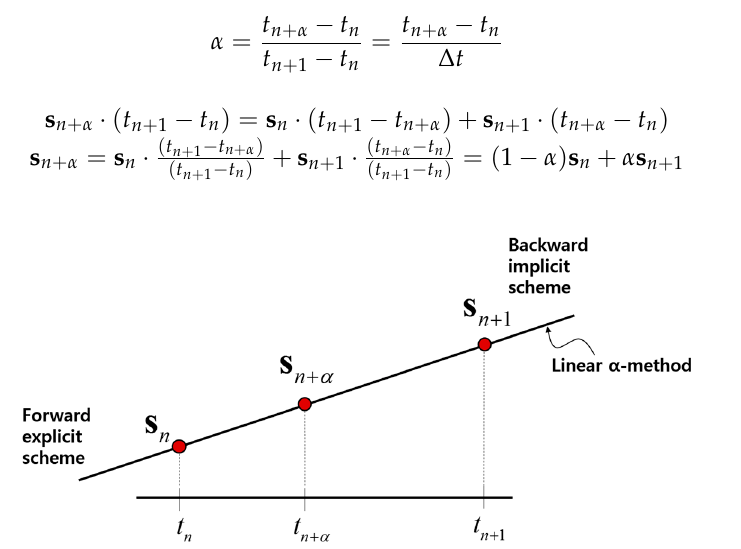
Figure 2. Time linearization for defining the midpoint deviatoric stress.